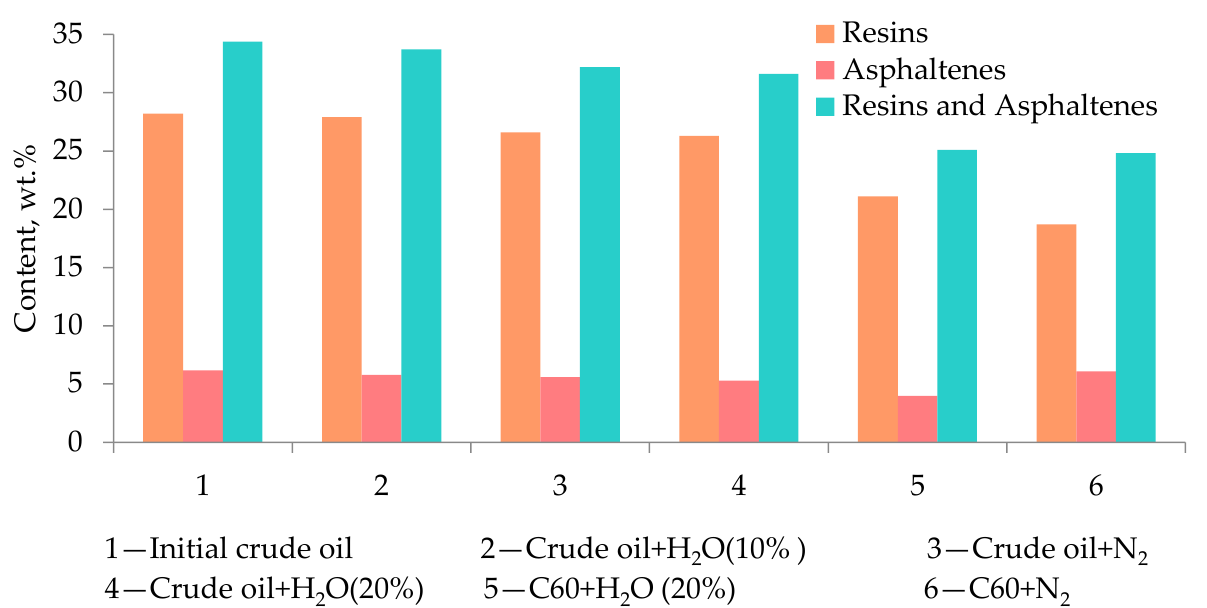
Figure 2. Changes in the contents of high-molecular-weight fragments of oil. Atmospheric oil distillation is the first step and a very informative approach to study- ing the chemical composition of heavy oil. The results of the atmospheric distillation of the heavy oil samples before and after thermolytic experiments are summarized in Table 1 and Figure 3. The initial boiling points (i.b.p.) of oil samples before and after experiments vary depending on the content of low-boiling hydrocarbon fractions. In turn, the boil- ing points of distillate fractions depend on the number of carbon atoms, light fractions, and the chemical structures of the compounds in the following order: normal alkanes < normal alkenes < iso alkanes < iso alkenes < alkyl cyclopentanes < alkyl cyclohexanes < alkylbenzenes < alkyl naphthalenes. The lowest boiling point temperature of an oil sample (98 ◦ C) was observed in the case of catalytic and water-assisted thermolytic upgrading. Apparently, the reductions in the overall length of the side chain, density, and refractive index of aromatic hydrocarbons led to a reduction in the boiling point. The distillates were roughly divided into two fractions in order to evaluate the yield of light components and, hence, the upgrading performance of fullerene C60 nanoparticles. The first fraction is the accumulation of heating products starting from the initial boiling point to a temperature of 200 ◦ C. This fraction corresponds to the gasoline distillates, which are composed of a mix- ture of alkane, naphthene, and aromatic hydrocarbons. Generally, in such hydrocarbons, the number of carbon atoms varies between 5 and 10. The yield of the gasoline fraction (i.b.p. 200 ◦ C) from the initial crude oil was 1.02%wt., while the catalytic thermolysis in the absence and presence of water (20%) drastically increased the yield by more than 2 and 4 times, respectively. This indicates the proposed mechanism of destructive hydrogenation of the most high-molecular-weight components of heavy oil and their conversion into light low-molecular-weight hydrocarbons such as saturates and aromatics. The second fraction is the gas oil fraction with a boiling point range of 200–300 ◦ C. This fraction is mostly composed of C10–C20 hydrocarbons. The maximum gasoil fraction yield (16.91%wt.) was observed after the thermolysis of heavy oil in the presence of water with a concentration of 20%. The content of total sulfur was almost unchanged for all the heavy oil